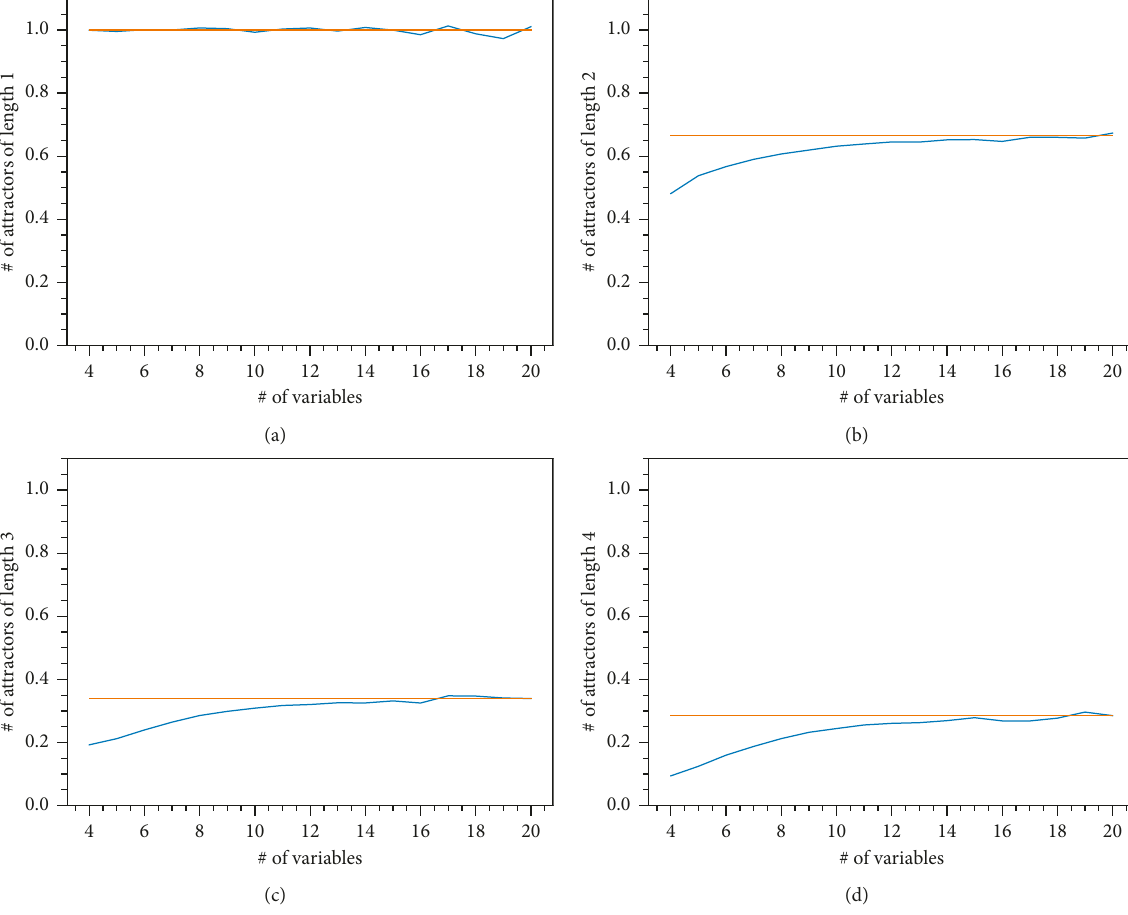
Figure 4: The average number of attractors of fixed length (blue plot) compared to the limiting value from Theorem 2 (orange plot). (a) Length 1. (b) Length 2. (c) Length 3. (d) Length